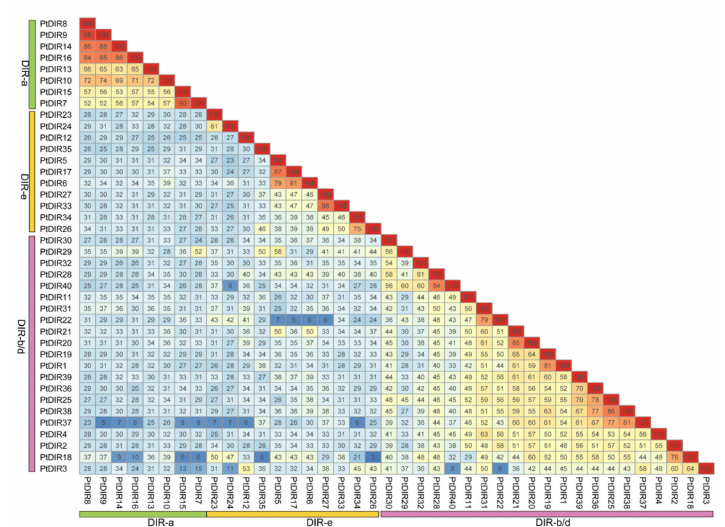
Figure 2. Identity matrix (percentage) of